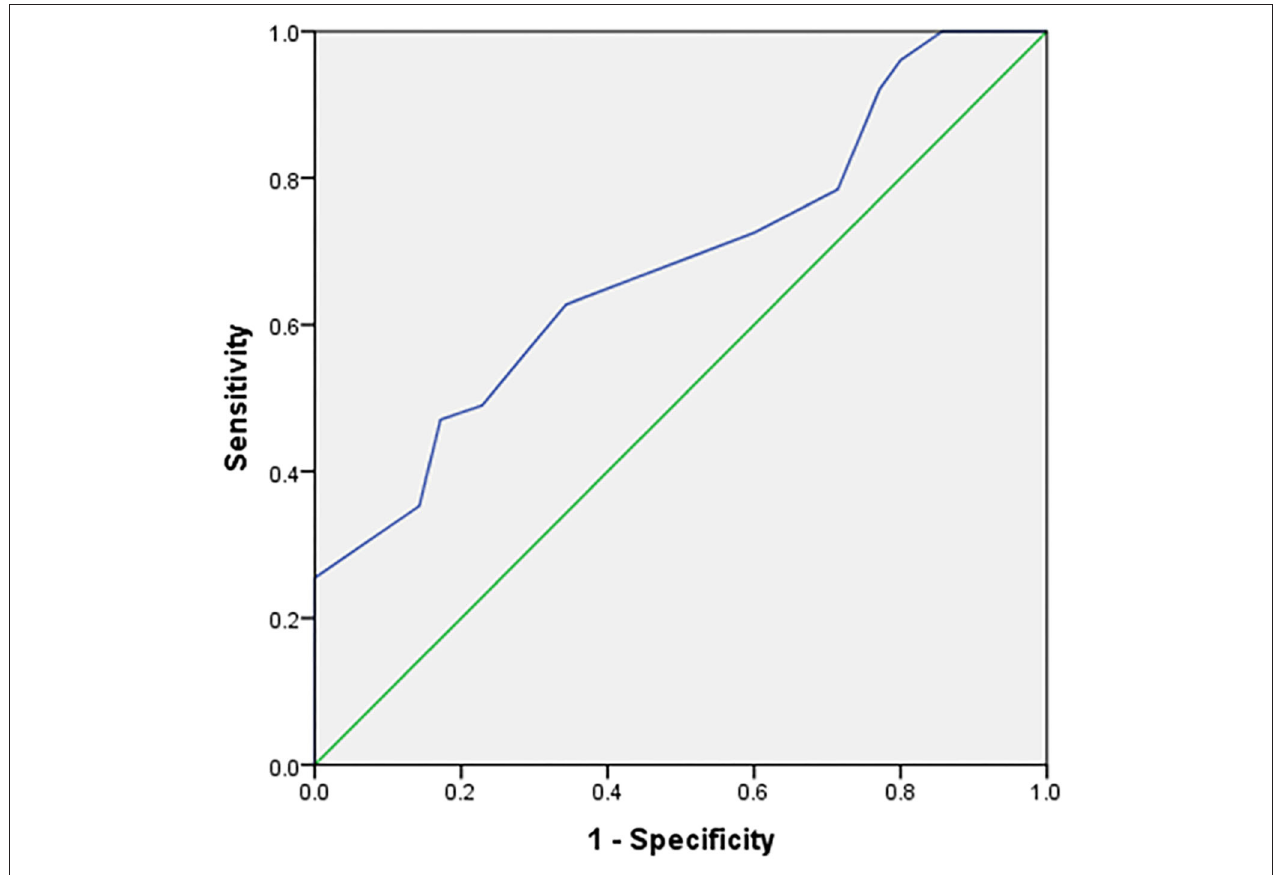
FIGURE 3 | The ability of SUV max to predict PD-L1 expression.